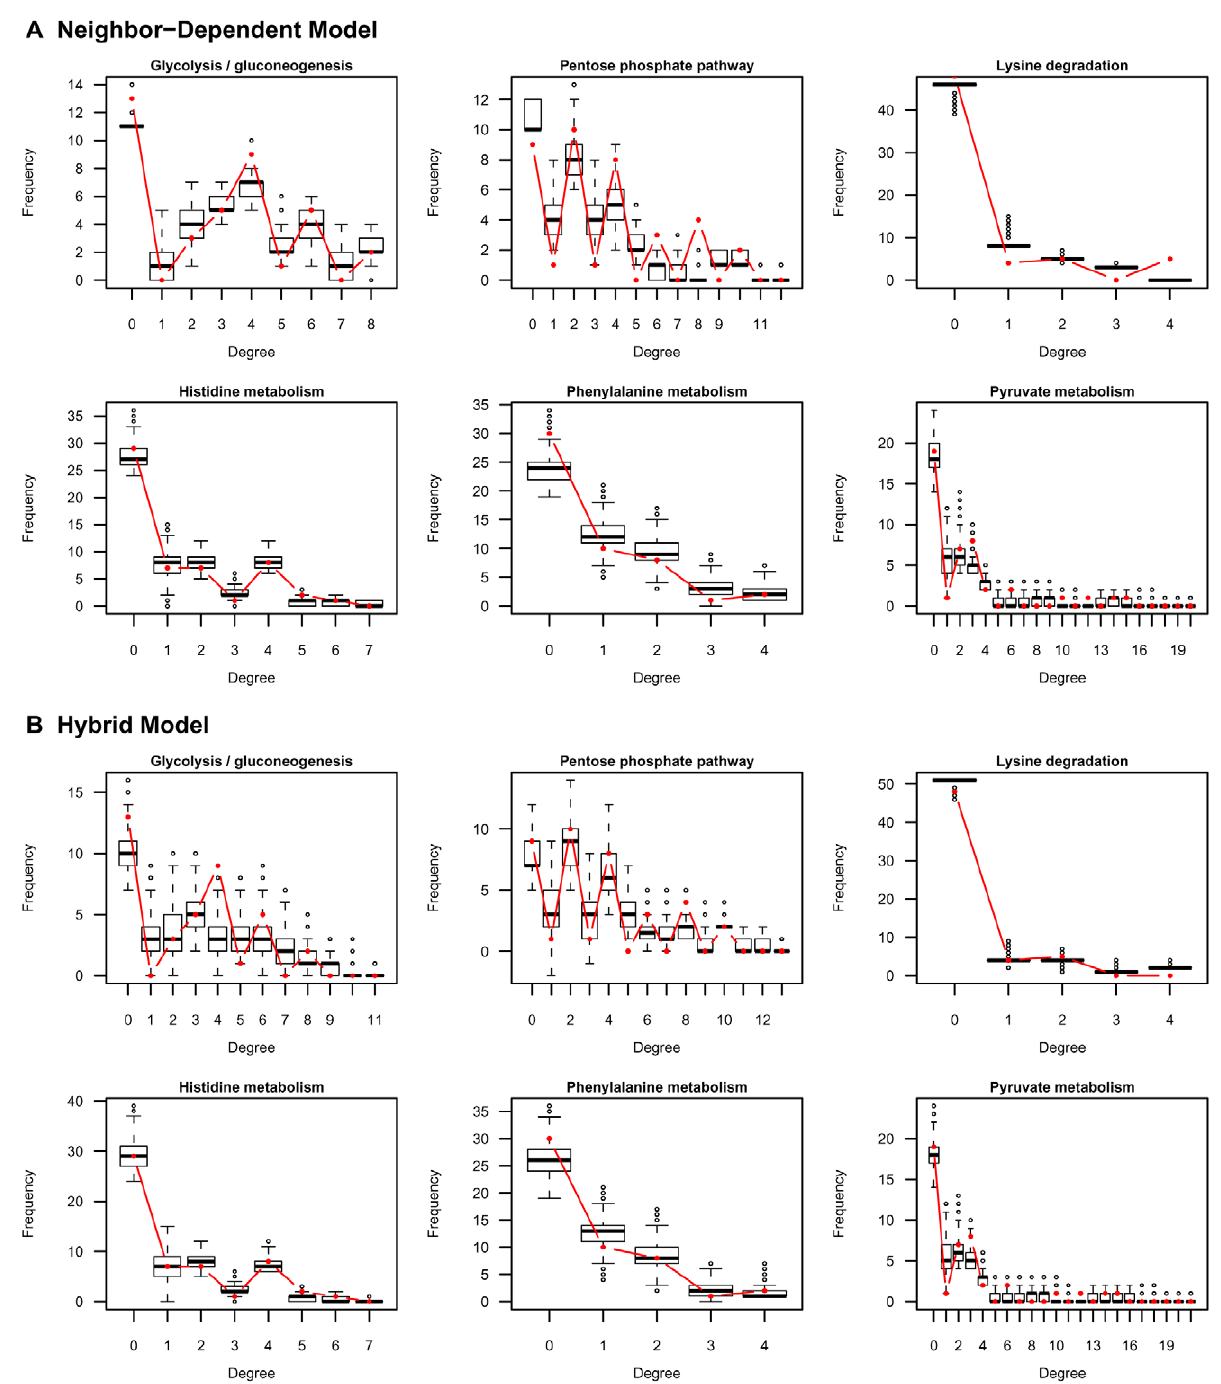
Figure 4. Degree distributions of nodes under the neighbor-dependent and hybrid models. Boxplots showing the degree distributions of nodes obtained by simulating the evolution for the pentose phosphate pathway, lysine degradation and phenylalanine metabolism maps in P. fluorescens Pf0-1 under (A) the neighbor-dependent model and (B) the hybrid model. The red line plots the actual degree distributions observed in the corresponding pathway map in P. fluorescens Pf0-1. each network across the seventeen Pseudomonas strains is given in sponding to the reactions not present in any of these seventeen Table S2. species were defined as prohibited edges. Three independent replicates of the sampler were run from random starting values for When estimating the parameters, the hyperedges corresponding 60,000 iterations for P. fluorescens and P. syringae phylogenies, and to the reactions that were common to all seventeen Pseudomonas 110,000 iterations for the phylogeny connecting the seventeen strains were defined as core edges and the hyperedges corre-